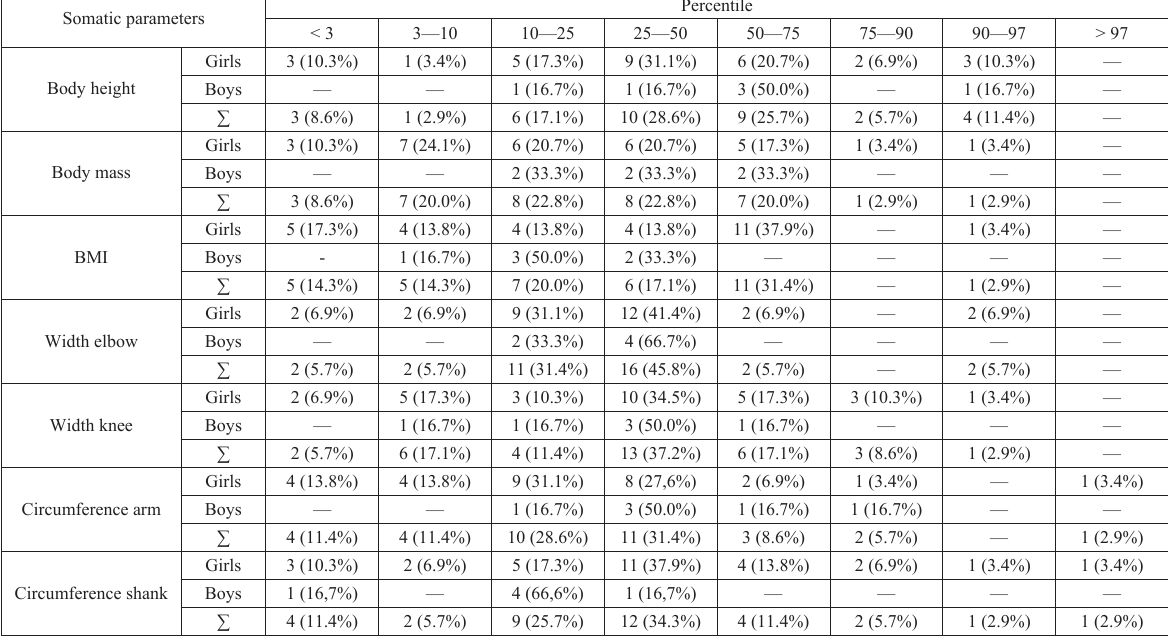
Note. Number of persons: girls = 29, boys =